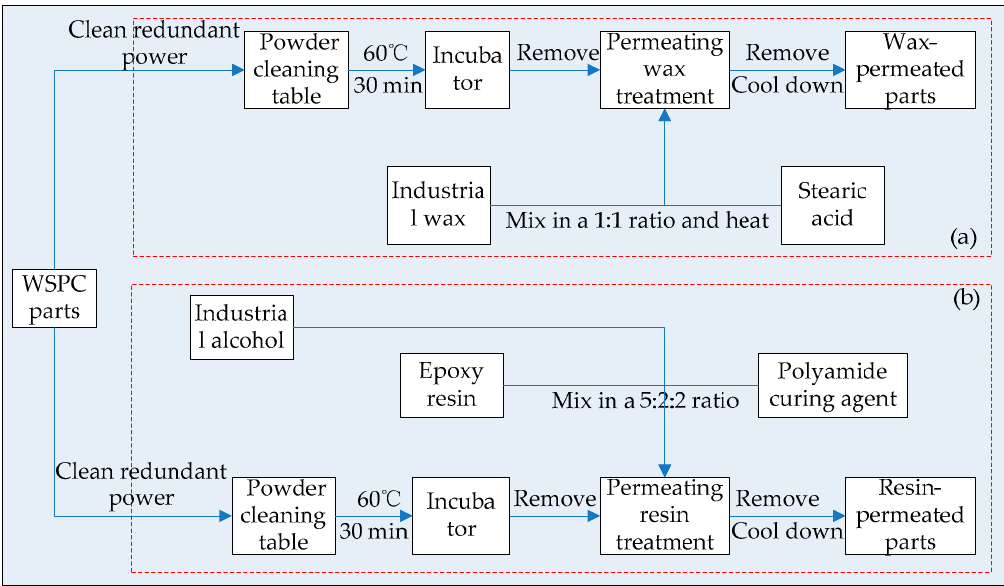
Figure 2. The equipment and building method.